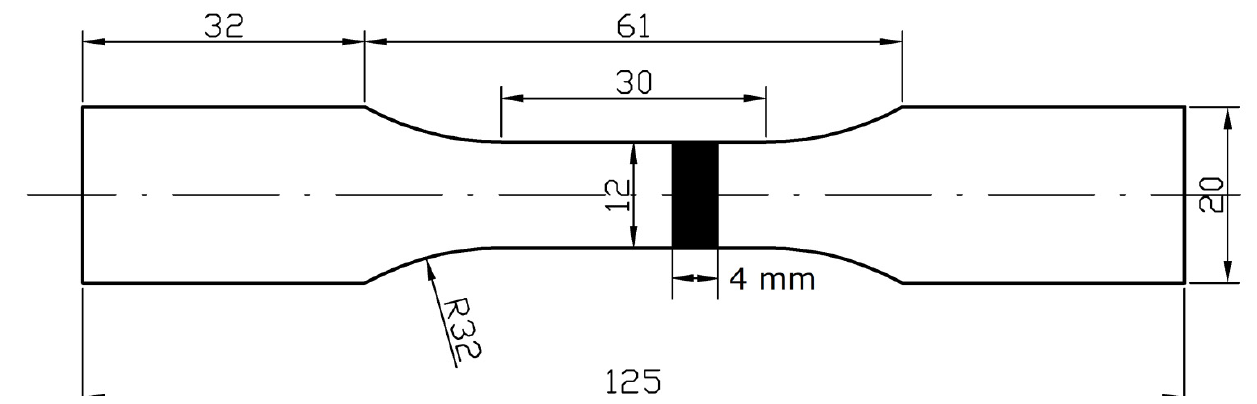
Figura 3: Provino, di spessore 3.2 mm, da cui è stato ricavato il campione di materiale analizzato